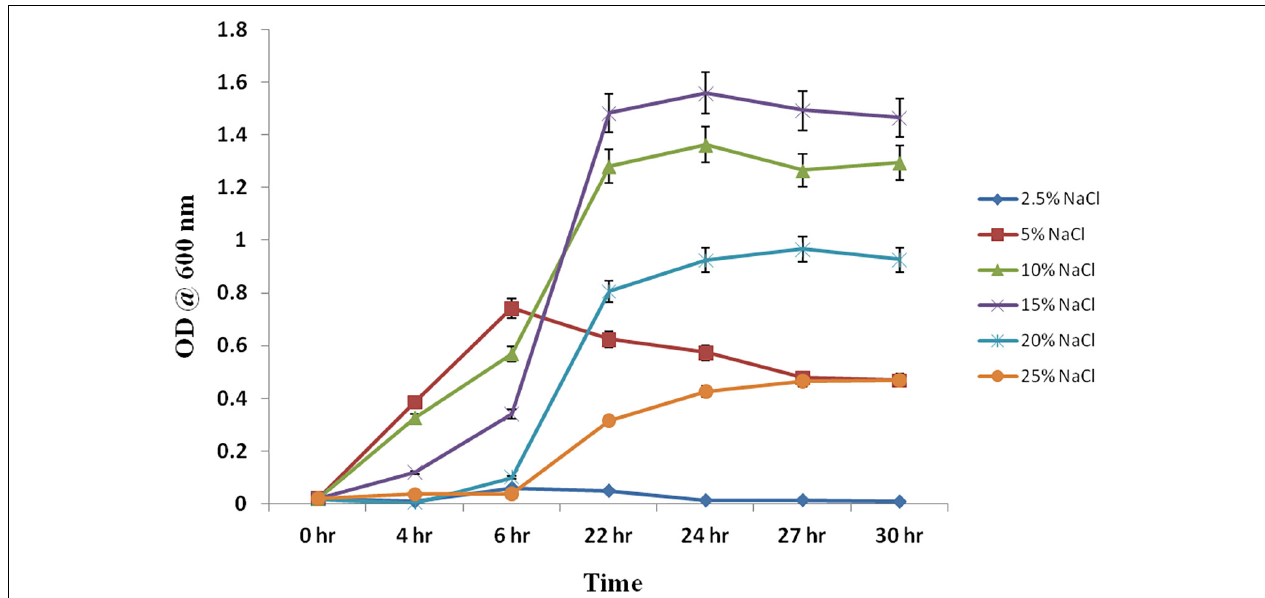
FIGURE 1 | Growth kinetics at different concentrations of the NaCl. Chromohalobacter salexigens ANJ207 was grown in the flask with the initial equal cell concentration at different concentrations of salt. The growth was monitored and OD 600 was calculated at different time intervals. OD 600 was plotted against different time intervals.